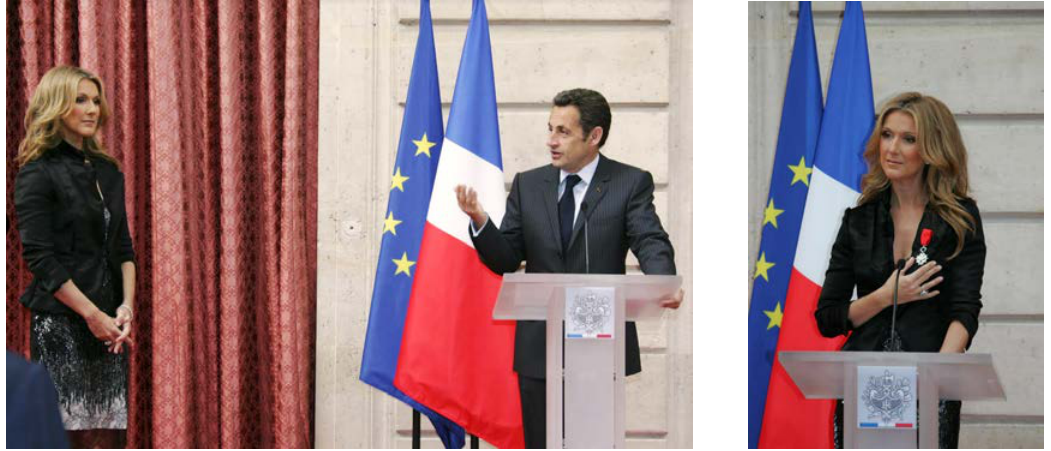
Figure 9: (left) Céline Dion receiving the Leg ion of Honour from France , President Nicolas Sarkozy in May, 2008. (right) Céline Dion’s discourse dedicating the medal to her French - Canadian family Source: Gulliver Trade, Romania, a master delegate of gettyimages,